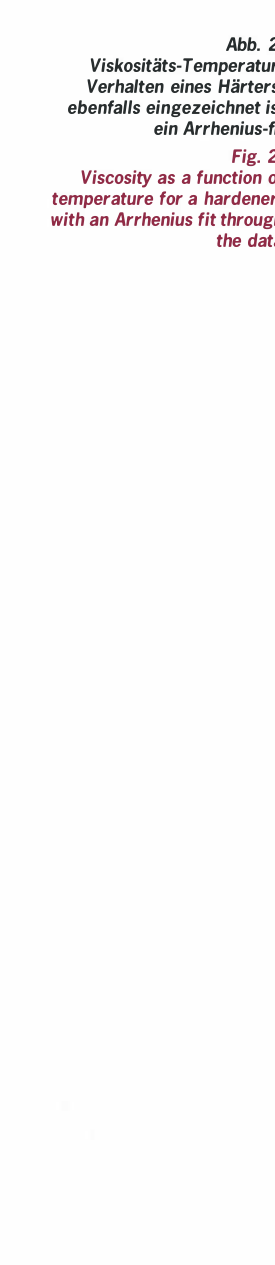
DSC curve for powder coating